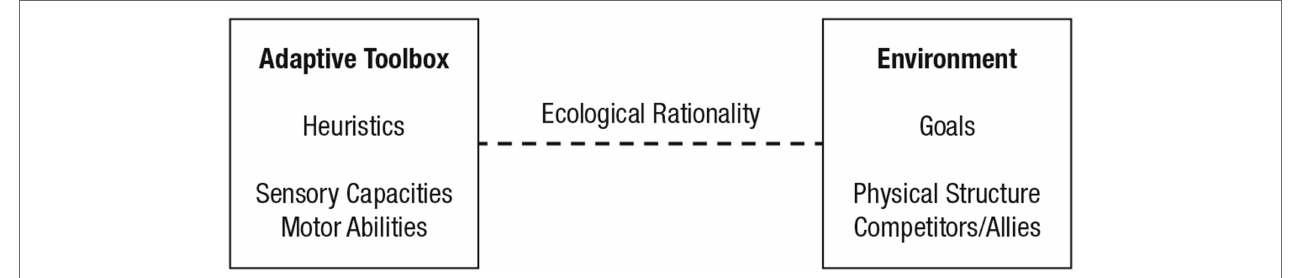
FIGURE 1 | Rationality as the match between heuristics and environment. Left side: The adaptive toolbox of an individual or species, with heuristics that are embodied in sensory capacities and motor abilities. Right side: The environment, including the goals of individual or species and their physical and social structure. The ecological rationality of a heuristic is measured by the degree to which it can attain a